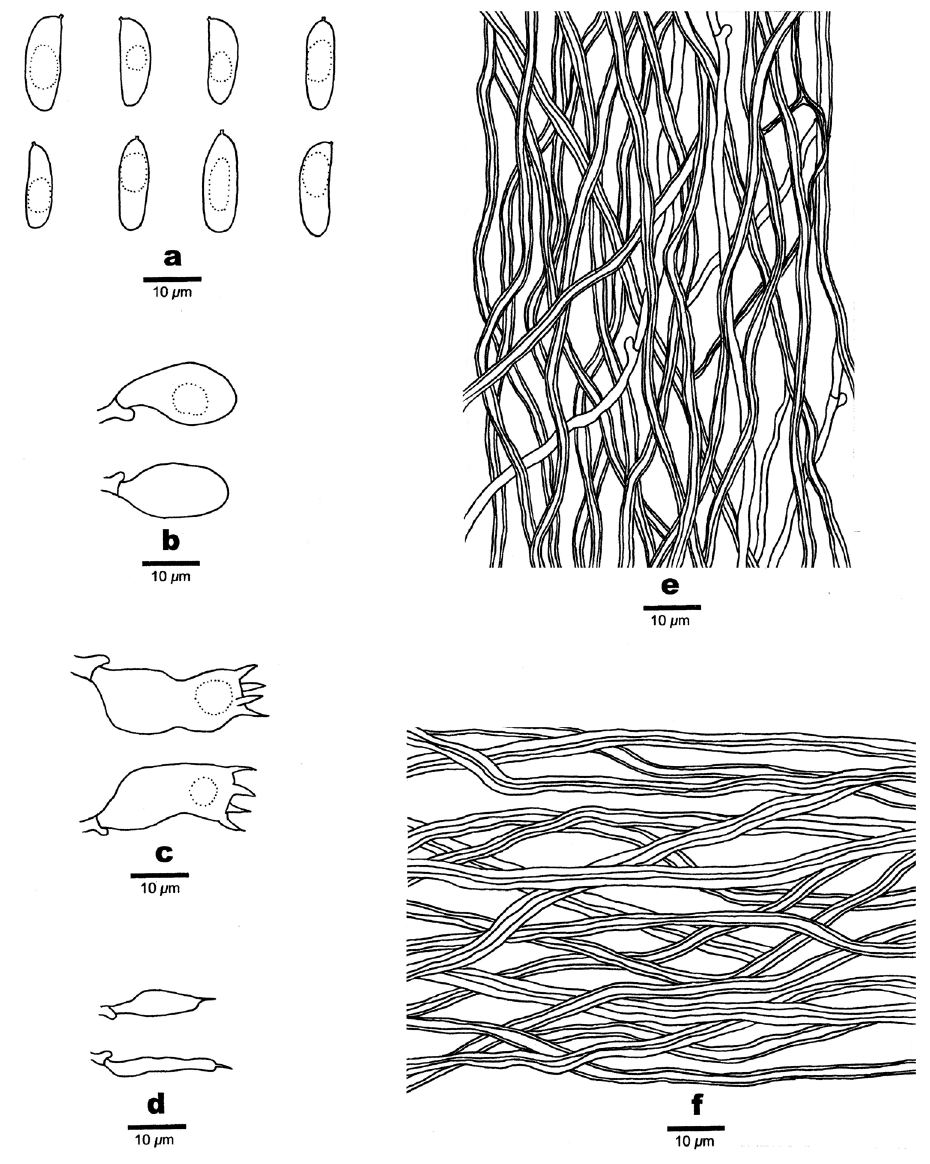
Figure 3. Microscopic structures of Megasporia tropica sp. nov. (drawn from the holotype). a Basidiospores b Basidio les c Basidia d Cystidioles e Hyphae from trama f Hyphae from subiculum. Holotype. CHINA. Yunnan Province, Kunming, Wild Duck Lake Park, on fallen angiosperm branch, 28 July 2014, Y.C. Dai 13870 (BJFC017600). Basidiocarps. Annual, resupinate, corky, without odor or taste when fresh, be- coming hard corky upon drying, up to 3 cm long, 2 cm wide, and 2 mm thick at centre. Sterile margin thinning out, white when dry, up to 1 mm wide. Pore